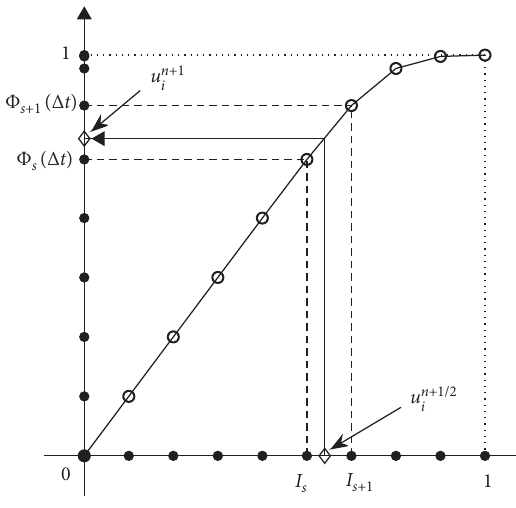
Figure 3: Semilogy plot of ( 1 − I Here, p � 10 is used.